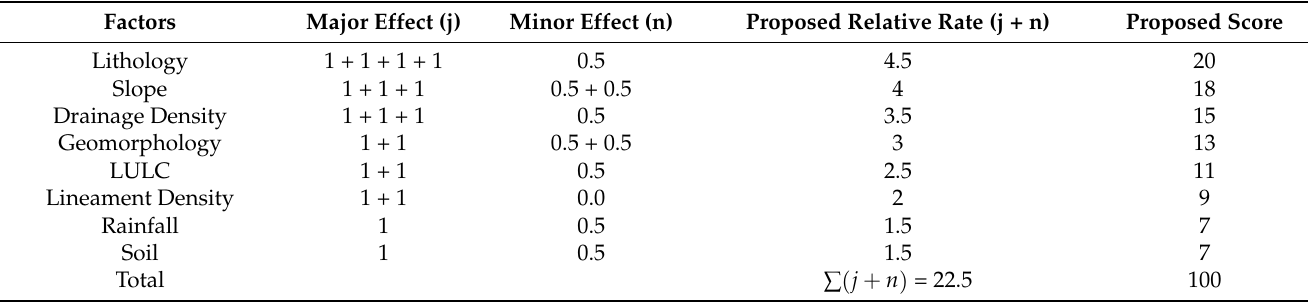
Table 2. MIF weight scores for groundwater potential zone